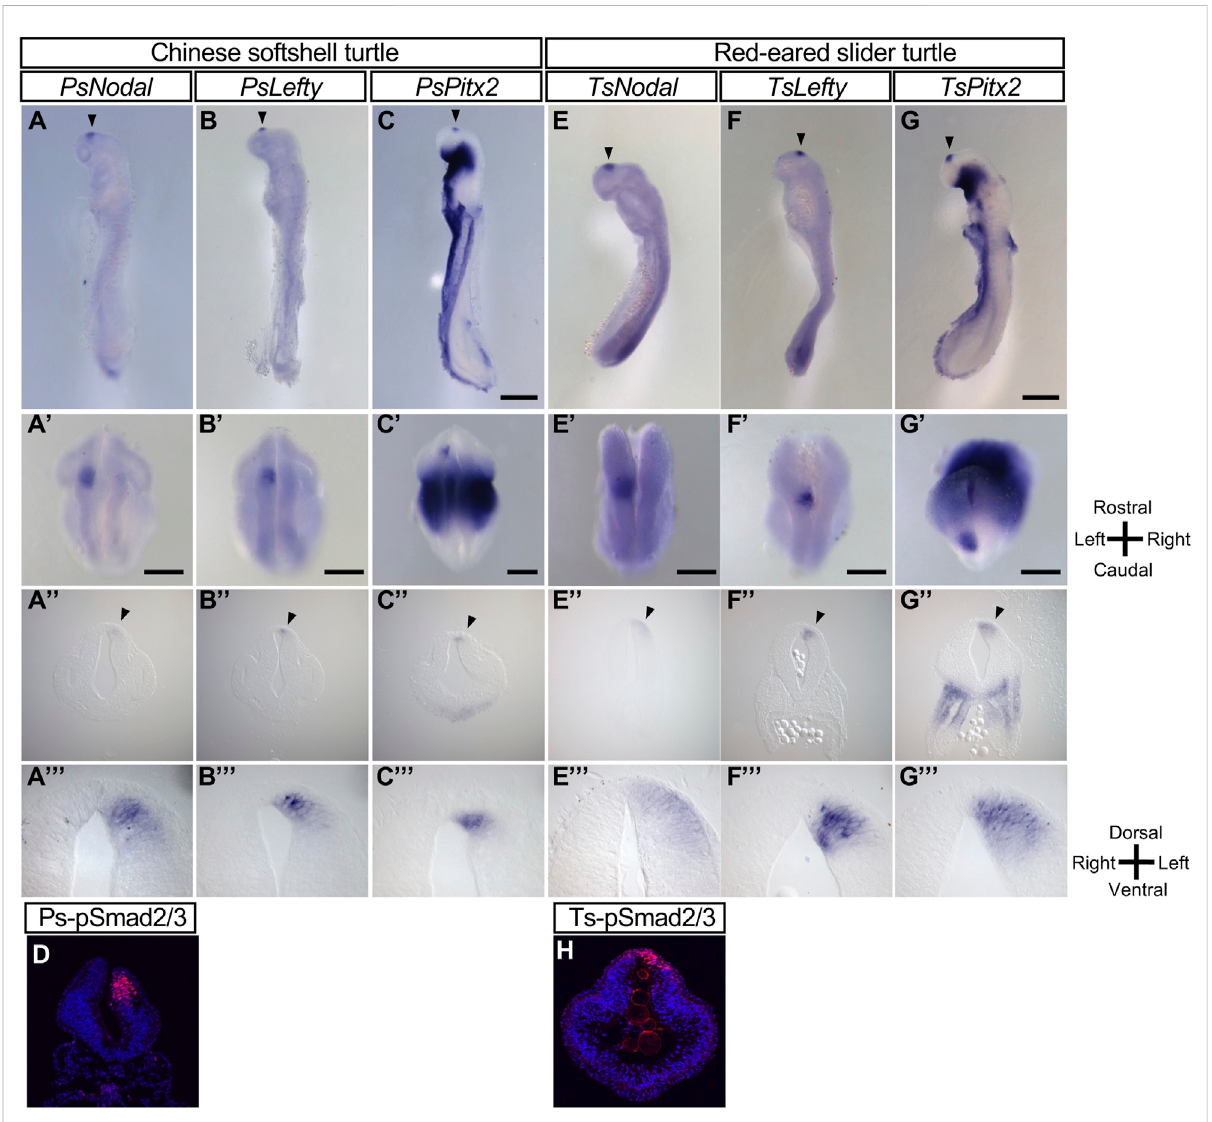
FIGURE 1 L-R asymmetric expression of Nodal , Lefty , and Pitx2 in the developing brain of the Chinese softshell turtle and red-eared slider turtle. (A – C) , (E – G) Whole-mount in situ hybridization analysis of the expression domains of Nodal (A,E) , Lefty (B,F) , and Pitx2 (C,G) in the developing brain of Chinese softshell turtle embryos at 3 dpo (A – C) and of red-eared slider turtle embryos at 4 dpo (E – G) . Top, middle, and bottom panels show left lateral views, dorsal views, and frontal sections, respectively. Domains manifesting L-R asymmetric expression are indicated by closed arrowheads. Rostral-caudal, dorsal-ventral, and L-R axes are indicated. Scale bars, 0.5 mm (top panels) and 0.2 mm (middle panels). Dorsal views, frontal sections, and higher magni fi cation images of frontal sections of embryo in (A – C) , (E – G) are shown in (A – C) , (E – G) , (A – C) , (E – G) , and (A – C) , (E – G) , respectively. (D,H) Nodal activity in Chinese softshell turtle (D) and red-eared slider turtle (H) embryos at 3 and 4 dpo, respectively, as determined by immuno fl uorescence staining of phosphorylated ( p ) Smad2/3 (red fl uorescence). Nuclei were stained with 4 ′ ,6-diamidino-2-phenylindole (blue fl uorescence). Nodal activity is asymmetric (L > R) in the